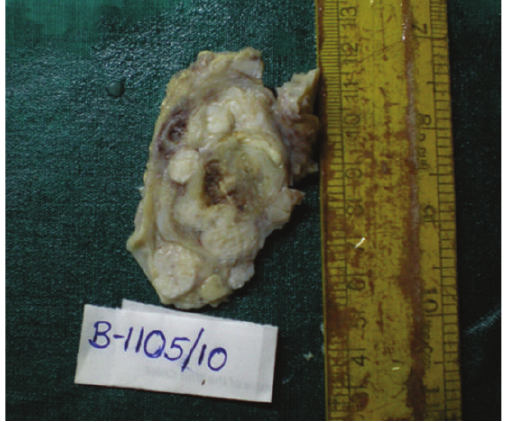
Figure 2: Cut section of specimen showing a large tumor with peripheral area of tumor showing satellite nodules.